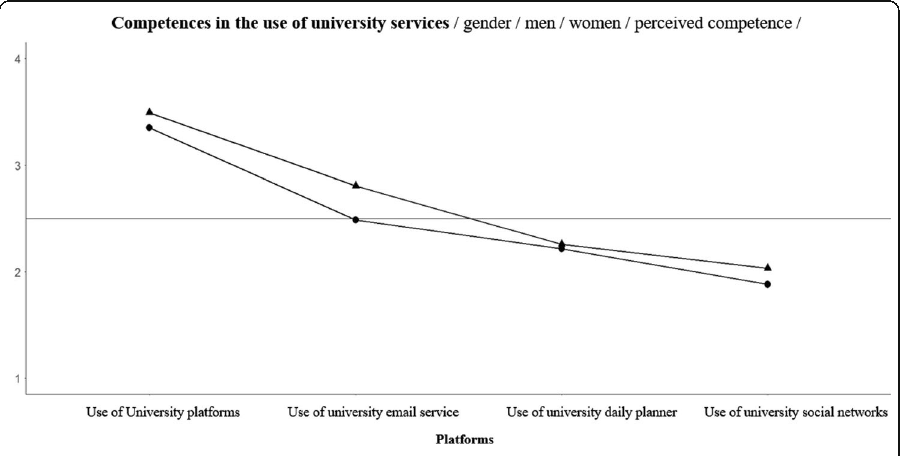
Fig. 4 Virtual and social communication tools at